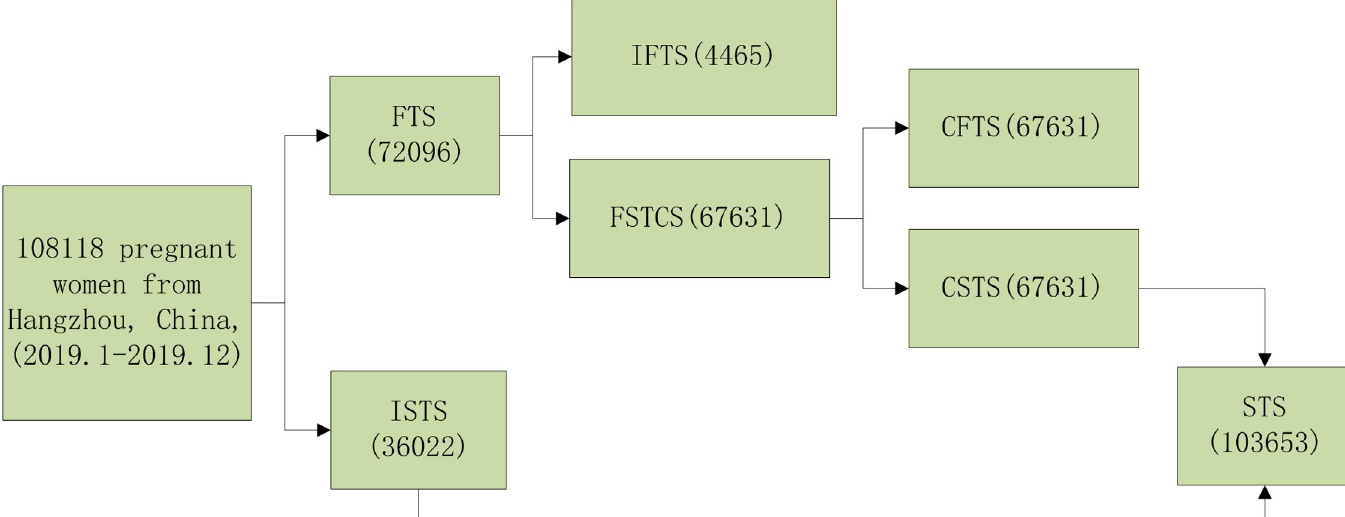
Fig 1. Prenatal screening program for 108,118 pregnant women. FTS: First-trimester screening; IFTS: Individual first-trimester screening; CFTS: Combined first- trimester screening; STS: Second-trimester screening; ISTS: Individual second-trimester screening; CSTS: Combined second-trimester screening; FSTCS: first- and second-trimester combined